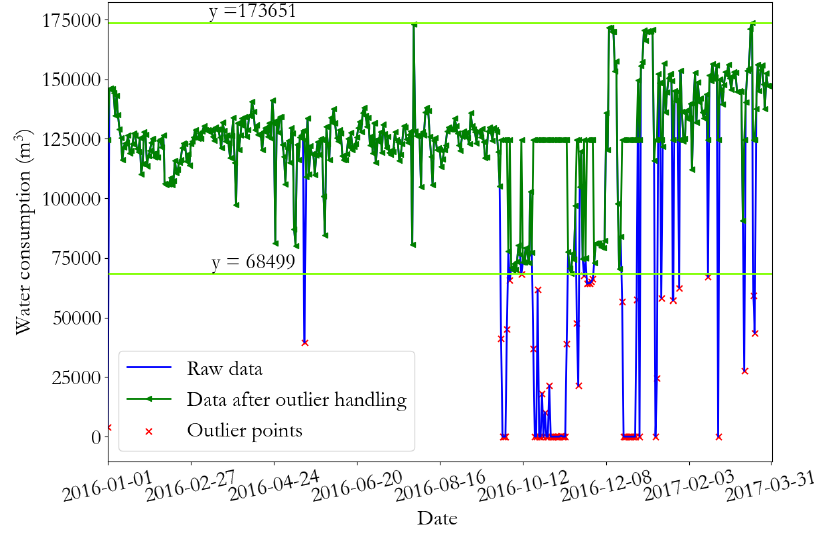
Figure 2. The original data and data after removing outliers of monitoring point 1.